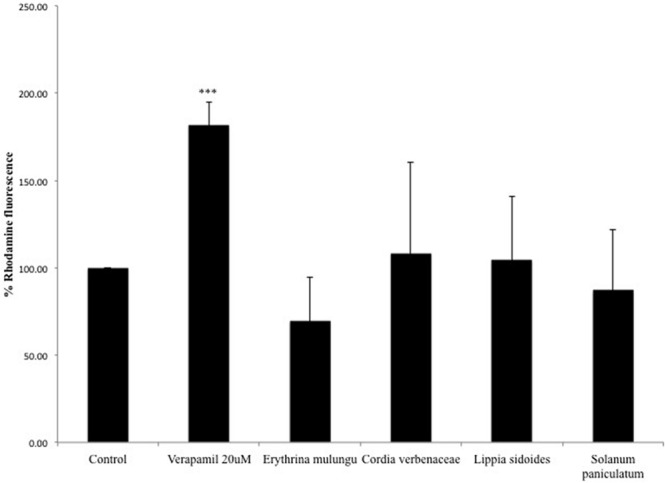
Rhodamine 123 fluorescence in vincristine resistant Caco-2 cells (Caco-2 VCR). Caco-2 VCR cells were treated with the P-gp inhibitor verapamil (20 μM) or plant extracts (100 μg/mL). Subsequently, cells were incubated with 5 μg/mL of rhodamine 123. Values are mean ± SD (n = 4).